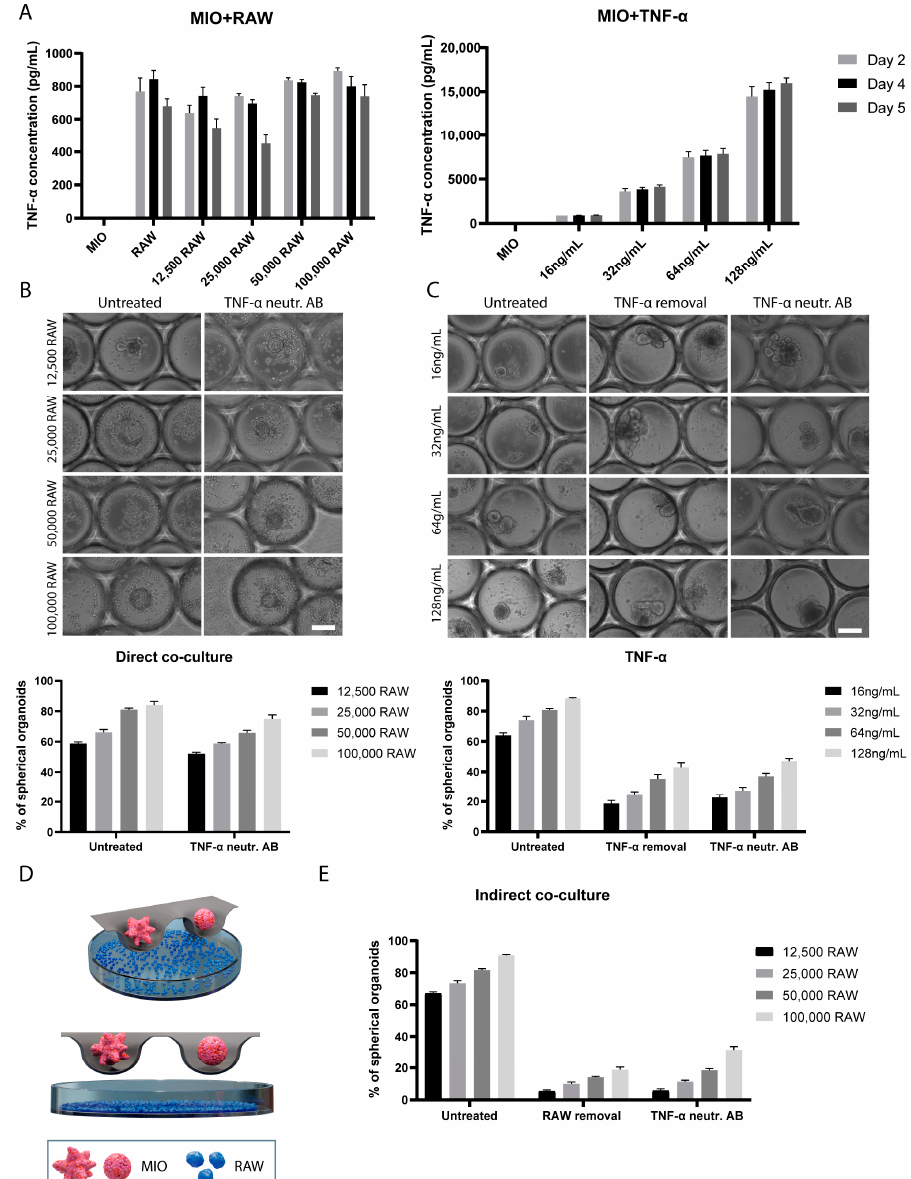
Figure 3. TNF ‐α‐ induced effects on organoid morphology. ( A ) Quantification of TNF ‐α concentration in the culture medium collected from organoids co ‐ cultured with macrophages (left) and TNF ‐α‐ treated organoids (right) over a period of 5 days. Data are presented as the mean ± SEM. ( n = 3). ( B ) Bright ‐ field images demonstrating the morphology of organoids co ‐ cultured with macrophages upon treatment with TNF ‐α neutralizing antibody (500 ng/mL). Graph indicates the percentages of spherical organoids with and without treatment. Data are presented as the mean ± SEM ( n = 3). Scale bar represents 200 μ m. ( C ) Bright ‐ field images demonstrating the morphology of TNF ‐α‐ treated organoids upon additional treatment with TNF ‐α neutralizing antibody (500 ng/mL) and upon removal of TNF ‐α on day 3. Graph indicates the percentages of spherical organoids with and without additional treatments. Data are presented as the mean ± SEM ( n = 3). Scale bar represents 200 μ m. ( D ) Schematic illustration of the indirect co ‐ culture of intestinal organoids with RAW 264.7 cells in microwell arrays. ( E ) Graph indicates the percentages of spherical organoids upon indirect co ‐ culture with macrophages, indirect co ‐ culture with subsequent removal of macrophages, and finally upon treatment with TNF ‐α neutralizing antibody on day 3 (500 ng/mL). Data are presented as the mean ± SEM ( n = 3). Abbreviations: MIO, mouse intestinal organoids; RAW, RAW 264.7 cells.